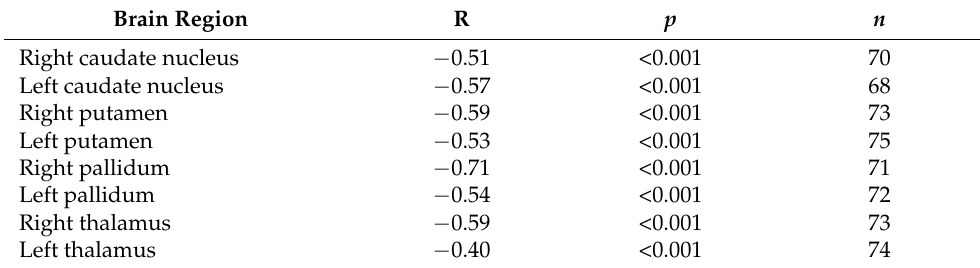
Table 3. Correlations between measured Glu and Gln concentration at each brain region estimated with Pearson’s correlation